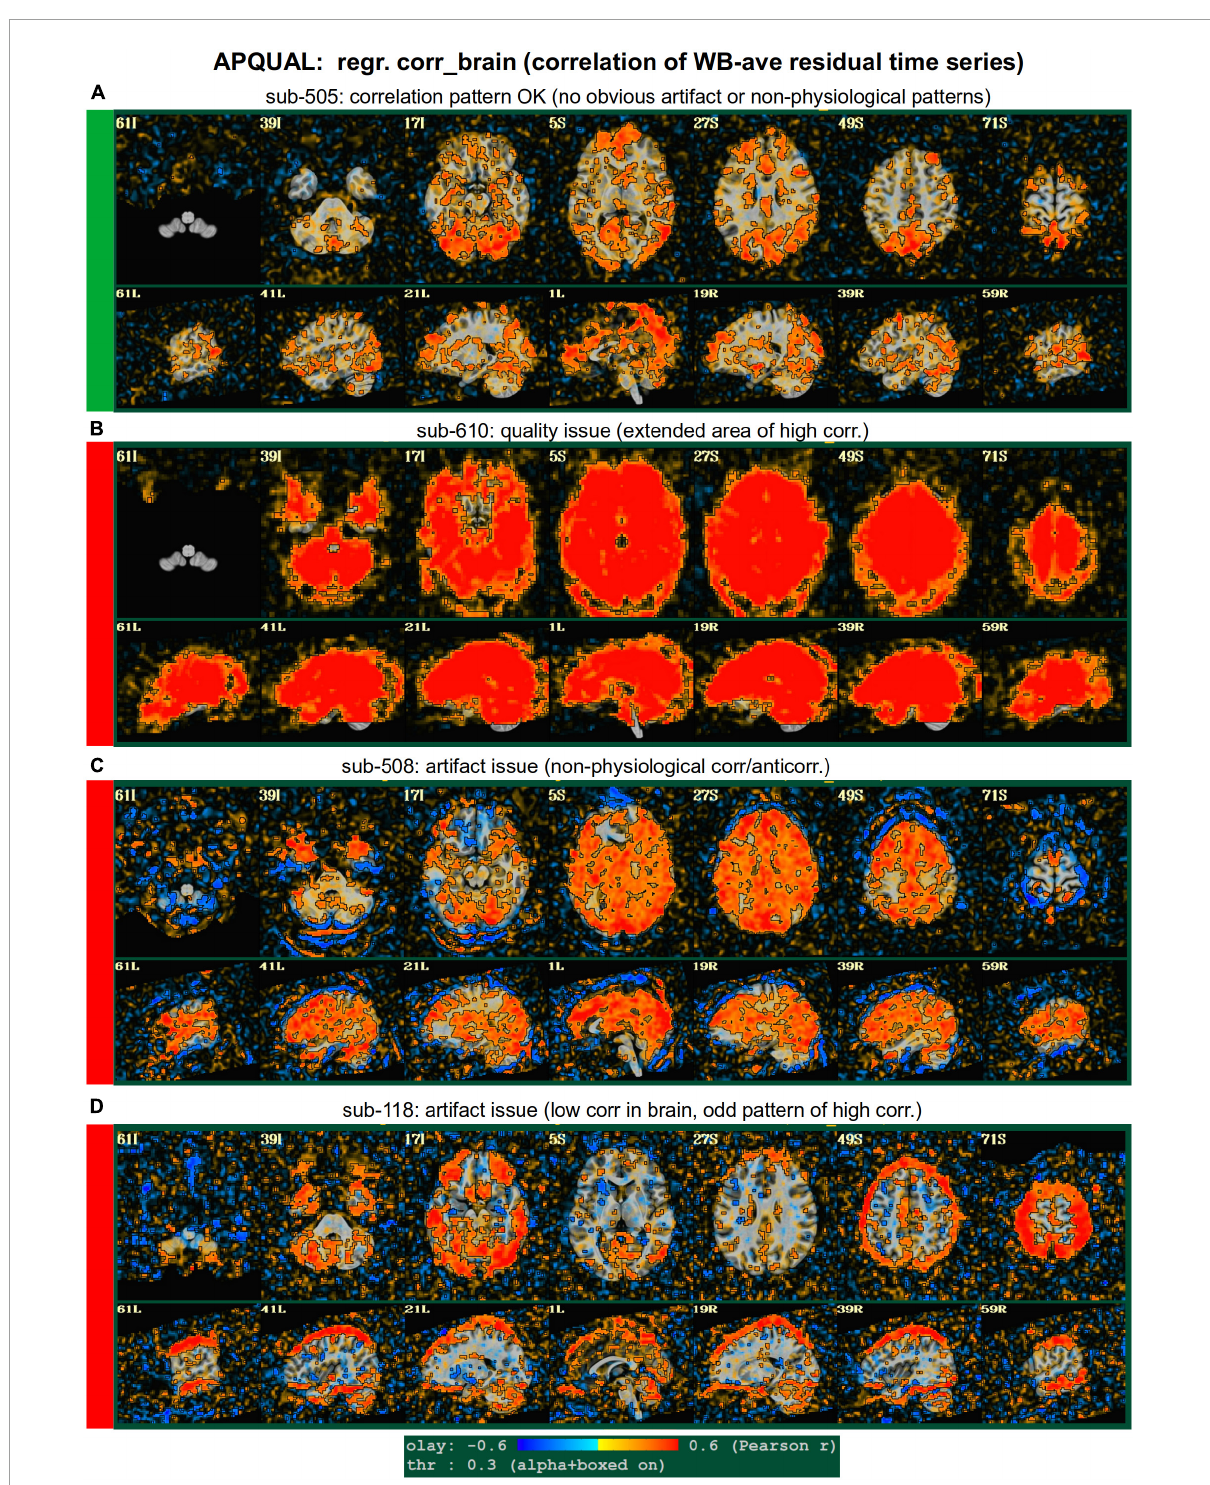
FIGURE6 APQUAL examples for the “regr” QC block: Regression evaluation through the correlation pattern of the brain-averaged residual time series (“corr_brain” maps). (A) Regions of low-medium correlation are mainly located through the GM. (B) The whole brain volume correlates highly with the global average, suggestive of strong non-physiological signals remaining in the data. (C) High correlation extends through the intracranial regions, with large negative filaments, suggestive of strong non-physiological signals remaining in the data. (D) Strong patterns of high correlation remain in the data, outside of